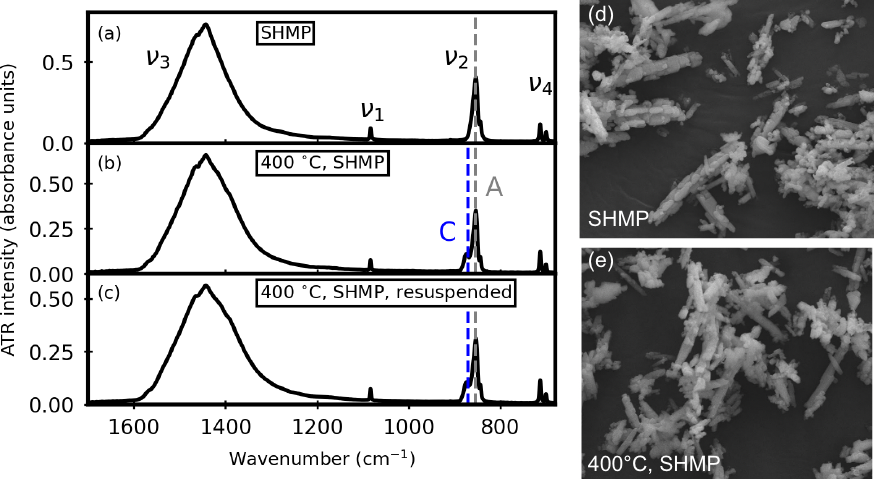
Figure 2. Representative ATR-FTIR spectra ( a – c ) and SEM images ( d , e ) for polyphosphate-treated powders (1-week suspension in 10 mM SHMP). The grey vertical line (858 cm − 1 , labelled A) corre- sponds to the aragonite ν 2 peak, while the blue vertical line (875 cm − 1 , labelled C) shows the calcite ν 2 peak. In all cases, the ATR-FTIR data show spectra comparable to the starting materials, with no additional peaks, and no discernable change in the relative aragonite:calcite peak intensities (compare with Figure 1a,e). The SEM images show that annealing to 400 ◦ C does not cause any discernable differences to the crystallite morphologies. Each image covers a width of 50 µ